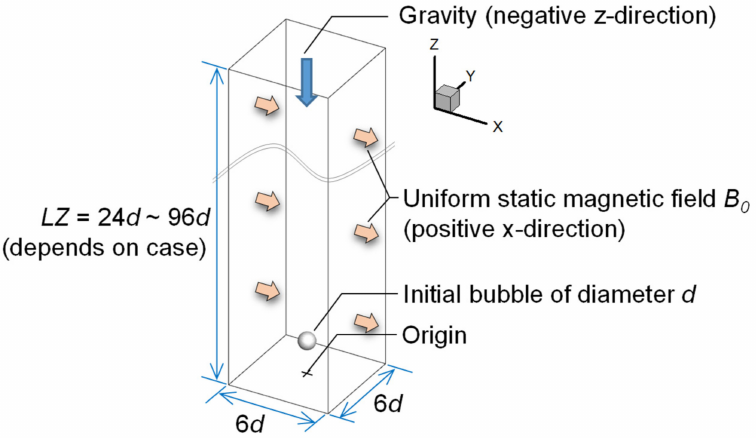
Figure 6. Computational domain size, the direction of the applied magnetic field and the orientation of the coordinate system for the rising bubble simulation. The domain is surrounded by no-slip